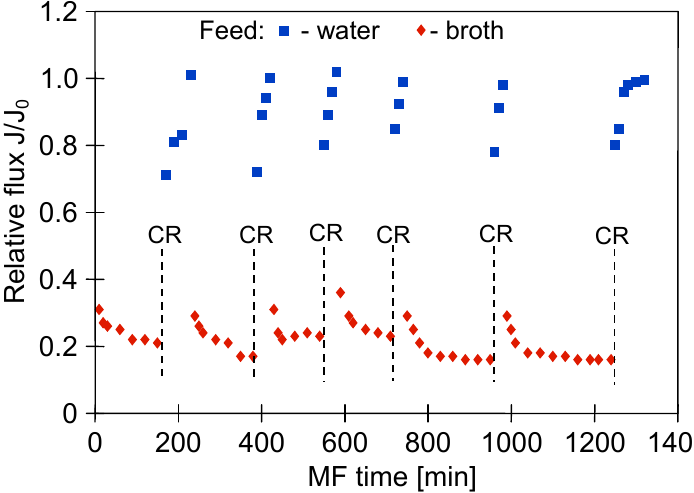
Figure 9. Changes in relative permeate flux during the long-term MF process of 1,3-PD fermentation broth with Citrobacter freundii , with periodically cleaning the module with 1% sodium hydroxide (NaOH) solution. Module M1, TMP = 0.03 MPa, V F = 0.8 m/s, CR—chemical